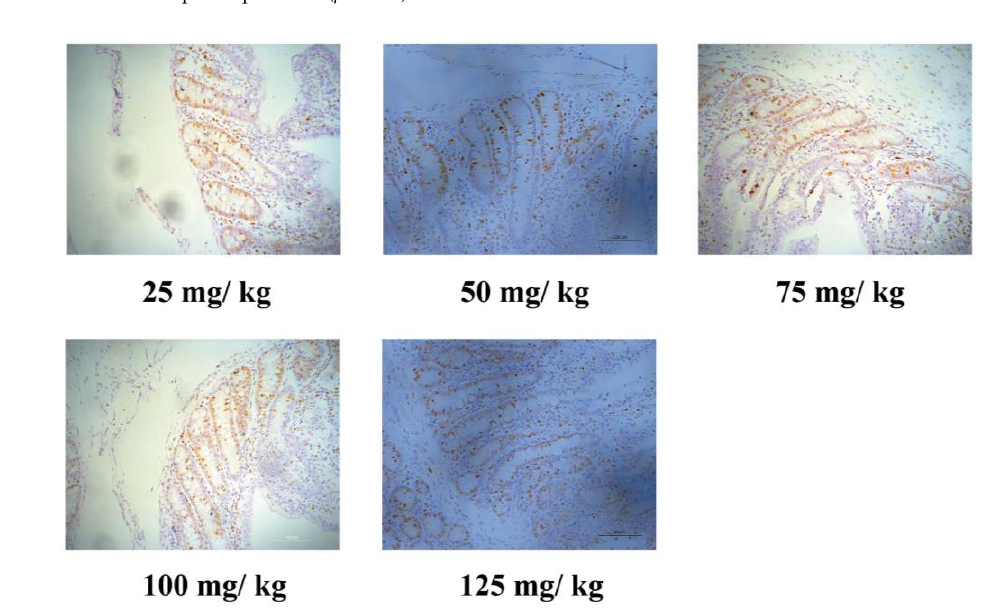
μmol/L CuSO 4 ·5H 2 O is presented in Figure 2. We found that 10 μmol/L CuSO 4 ·5H 2 O sig- nificantly increased ( p < 0.001) organoid budding efficiency, crypt depth, and crypts per organoid compared to the control pigs (Figure 2B). However, 100 μmol/L CuSO 4 ·5H 2 O inhibited ( p < 0.001) the organoid budding efficiency and the crypts per organoid. Figure 2. Effect of copper concentration on intestinal stem cells activity of piglets. ( A ) Representative images of organoid morphology after 0, 10, and 100 μmol/L CuSO 4 ·5H 2 O treatment in vitro. Scale bars, 50 μm (magnification 50×). ( B ) Organ- oid budding efficiency, budding crypt depth, and crypts per organoid at three days after CuSO 4 ·5H 2 O treatments were quantified. Statistical significance was determined by one-way ANOVA. The results are expressed as the means and SEM ( n = 6 wells per treatment; *** p < 0.001).